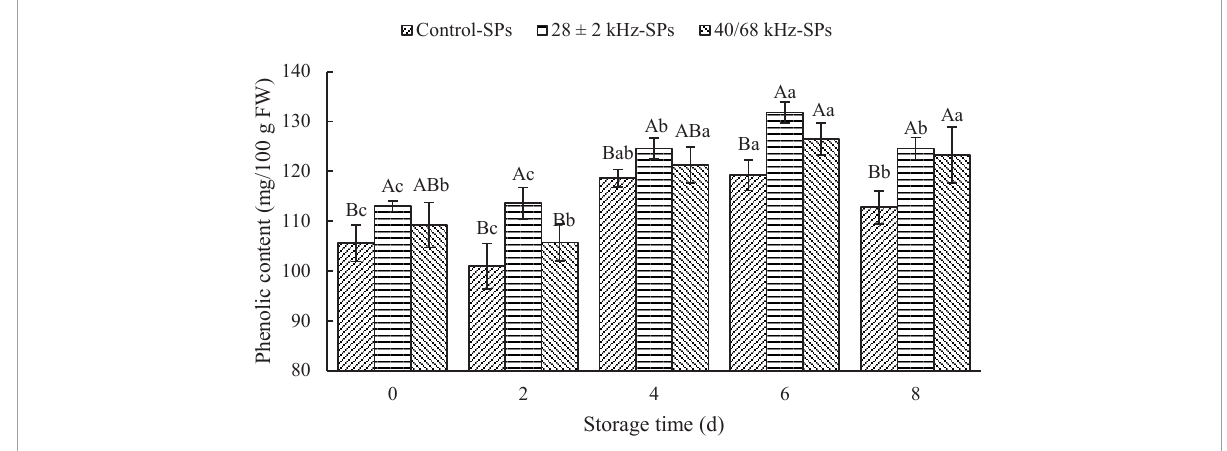
FIGURE2 Effects of the optimal single-frequency and dual-frequency mode on the content of soluble phenolics (SPs) in fresh-cut red cabbages. The results represent the means of three triplicates ± standard deviations. Different capital letters mean that the effects of different treatments for the same day are significantly different ( P < 0.05); different lowercase letters mean that the effects of storage times for the same treatment are significantly different ( P < 0.05). Control: fresh-cut red cabbages were washed with sterile distilled water; treatment: ultrasonic power density of 60 W/L, frequency cycle time of 500 ms, and ultrasonic time of 15 min.